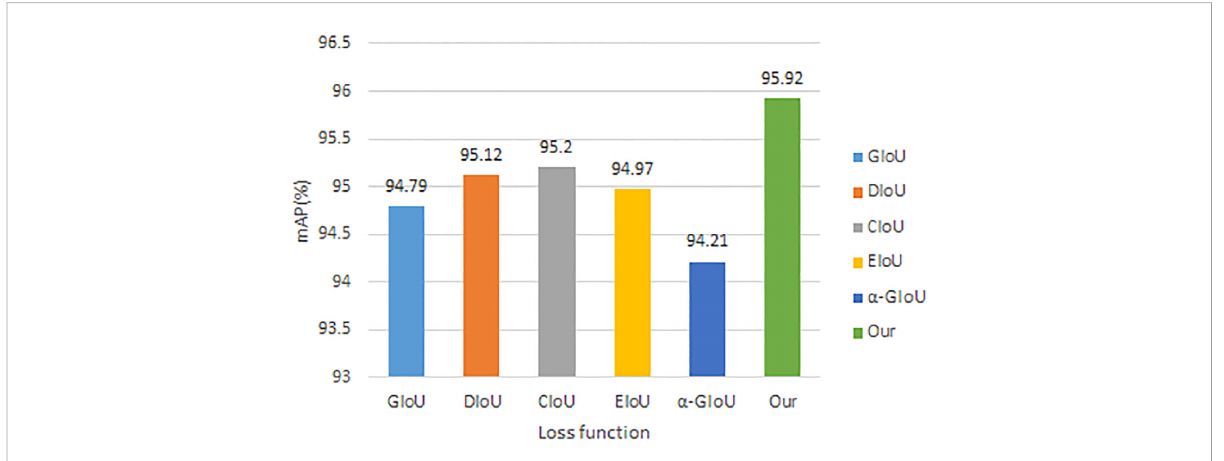
FIGURE 12 Comparison results of different loss